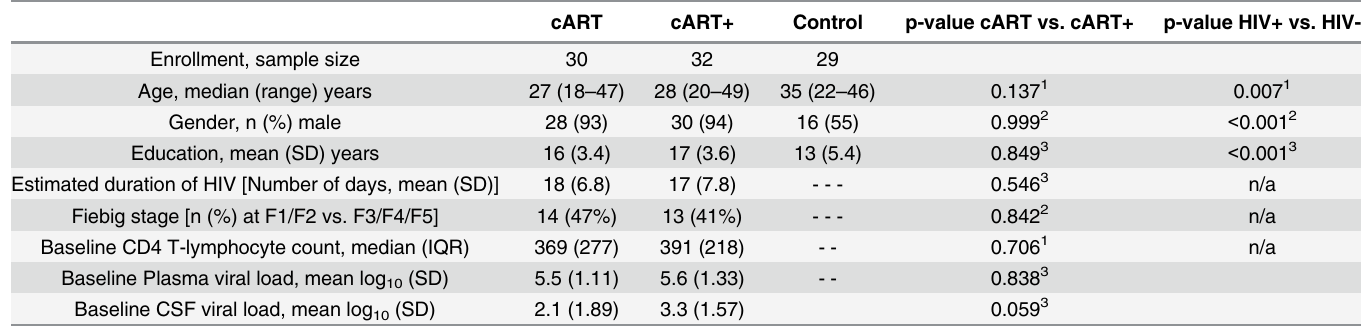
Table 1. Baseline characteristics of the two treatment arms and comparison of HIV-infected to HIV-uninfected controls. cART cART+ Control p-value cART vs. cART+ p-value HIV+ vs. HIV-